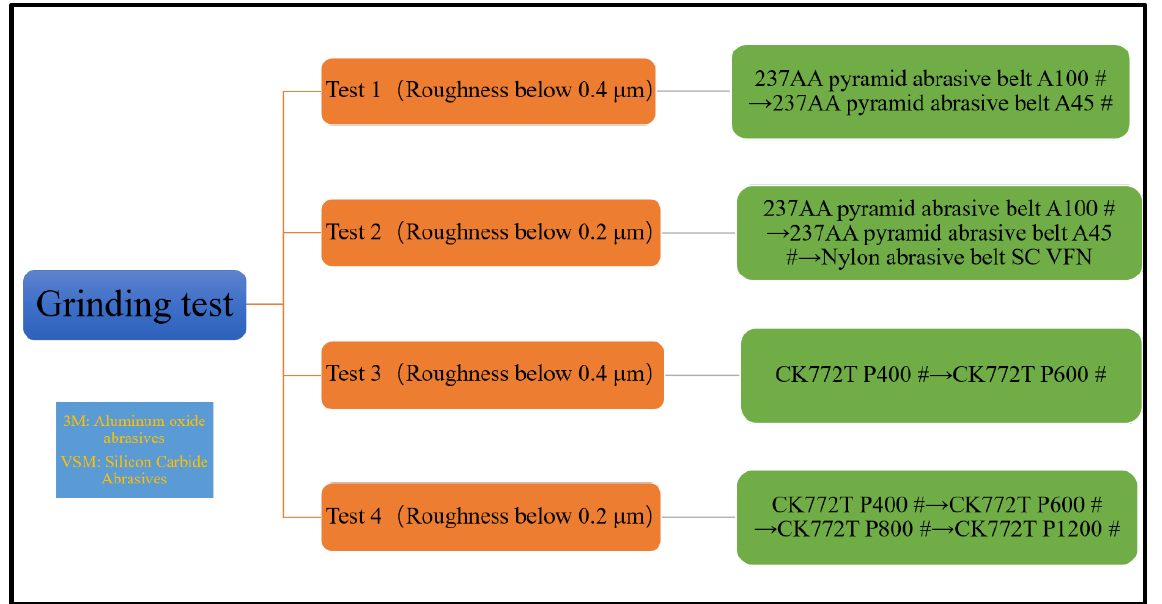
Figure 3. Grinding test abrasive belt sequence flow chart.